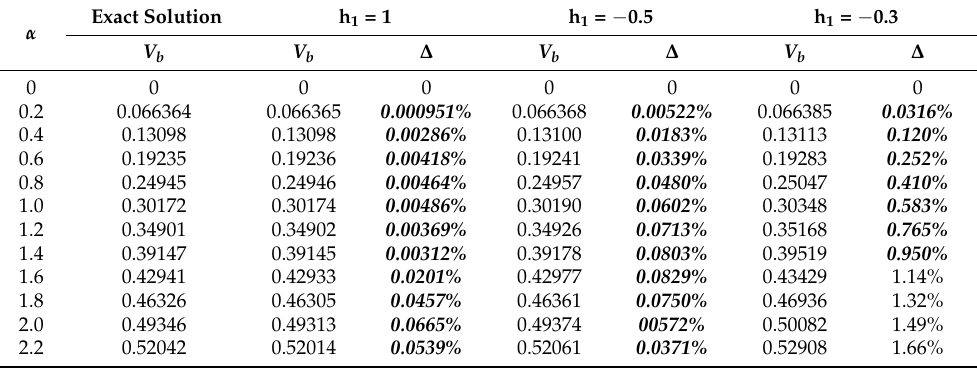
10th-order numerical solutions V